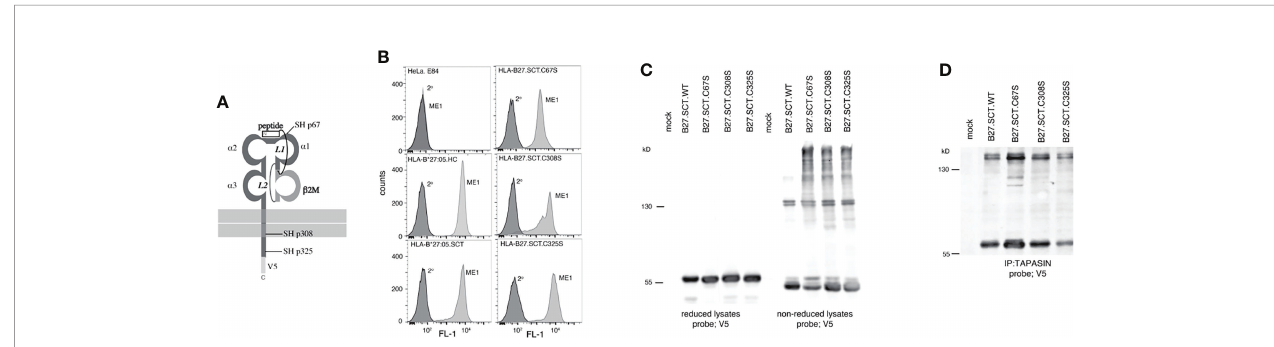
FIGURE 4 | Unpaired cysteines at p67, p308 and p325 do not alter the ability of the HLA-B27.SCT to dimerise within the PLC. (A) Diagram illustrating the unpaired cysteine (-SH) residues at p67, 308 and 325 within the HLA-B27.SCT molecule. (B) Flow cytometric analysis of HeLa cells expressing HLA-B*27:05 heavy chain, HLA-B*27:05.SCT, B27.C67S.SCT, B27.C308S.SCT and B27.C325S.SCT. All constructs were detected by staining with the conformationally dependent ME1 antibody. Note HeLa cells were negative for ME1 staining. (C) Mutating each of the unpaired cysteines does not alter the dimerisation of the HLA-B27.SCT as detected in whole cell lysates. Immunoblotting of NEM treated cell lysates with the anti-V5 antibody revealed high molecular weight dimeric structures for HLA- B*27:05.SCT and the respective cysteine mutants. Dimeric structures are not evident following reduction. (D) HLA-B27.SCT cysteine mutants dimerised within the PLC. HeLa cells expressing the respective HLA-B27.SCT cysteine mutant constructs were NEM treated followed by lysis in 1% digitonin. Each was immunoprecipitated with anti-tapasin antibody, resolved by non-reducing 8% SDS-PAGE and immunoblotted with the anti-V5